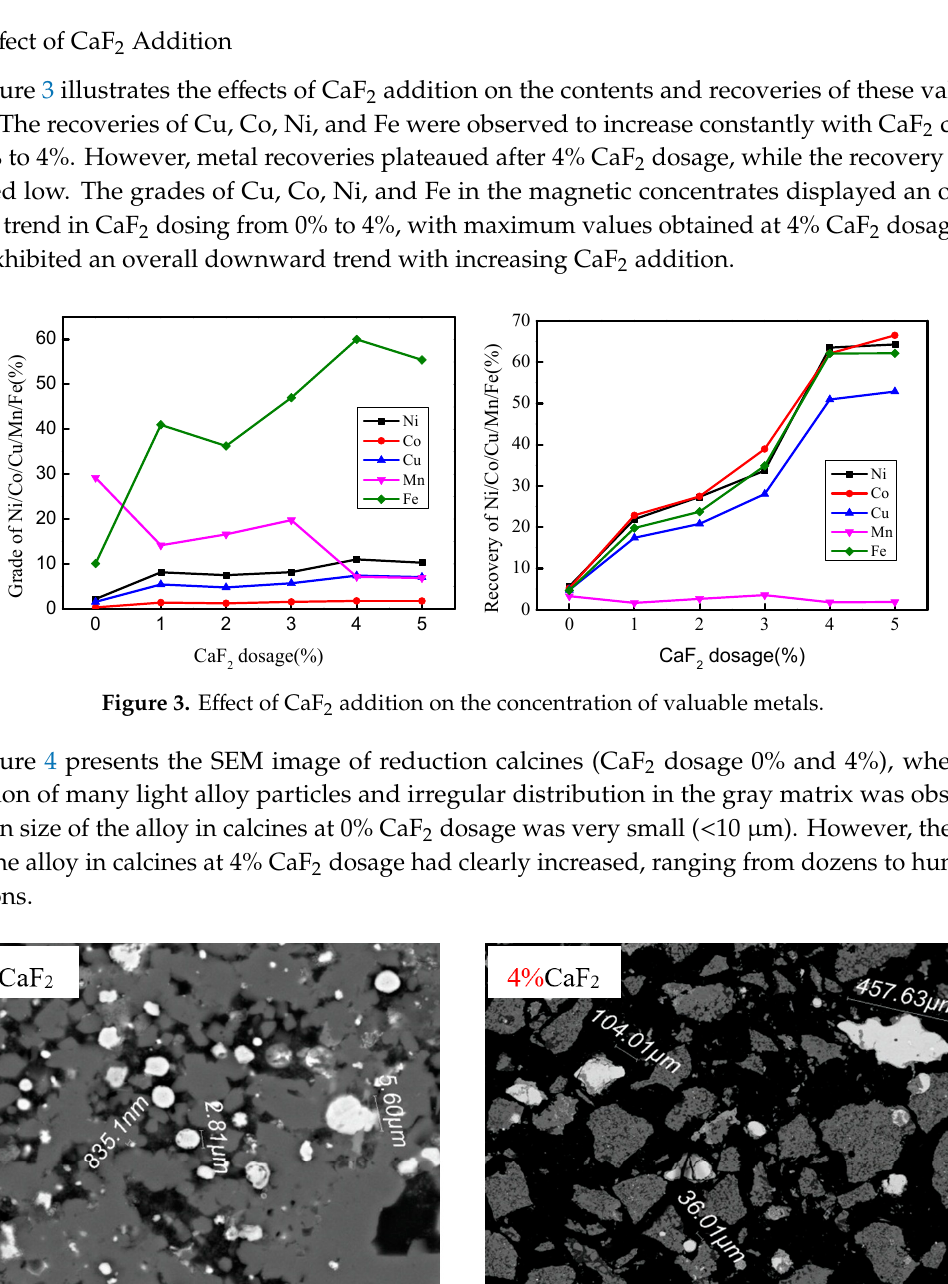
Figure 4. Scanning electron microscopy (SEM) image of the reduction calcines in 0% and 4% CaF 2.